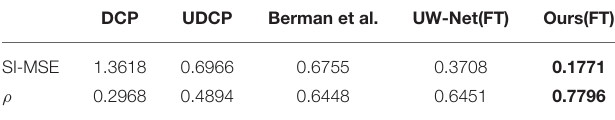
TABLE 2 | Quantitative comparison of our method and other methods on the TABLE 3 | Comparison of Floating Point Operations (FLOPs) and total number of dataset of Berman et al. (2017). parameters among different generators with a size of 256 × 256. Berman et al. Methods